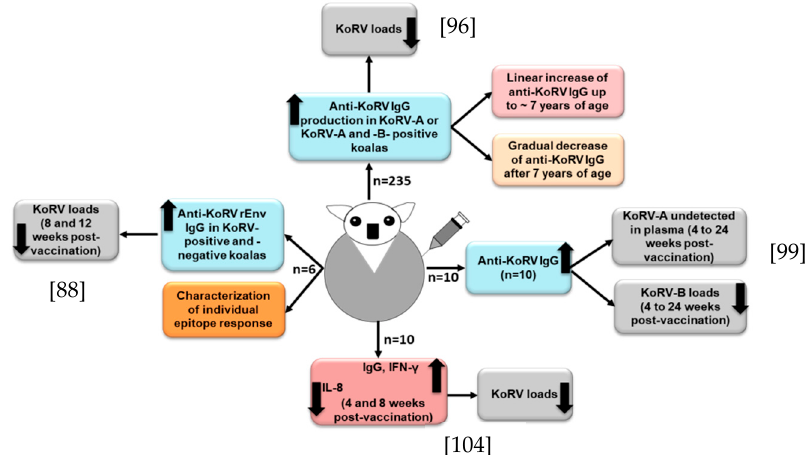
Figure 3. Cartoon shows KoRV vaccine responses in KoRV-infected koalas. In each case [88,96,99,104], anti-KoRV IgGs were developed and viral loads were reduced.